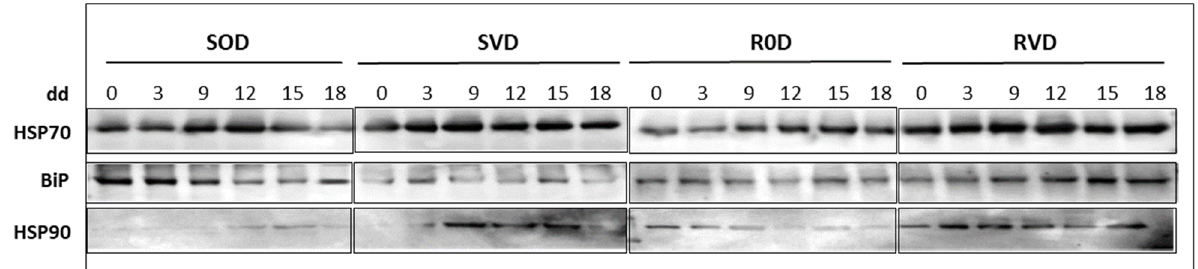
Figure 2. Heat shock proteins (HSPs) patterns shown for HSP70, BiP, and HSP90. Twenty milligrams of dried leaves from three different plants were taken for each sample. Plant tissues were drill-homogenized in 300 µL of SDS-PAGE buffer. Thirty µL of protein extracts were subjected to SDS-PAGE. HSP70, BiP, HSP90 were immuno-detected using specific antibodies. The photographs show the relevant regions of the gel. Three independent biological repeats were used with similar results.